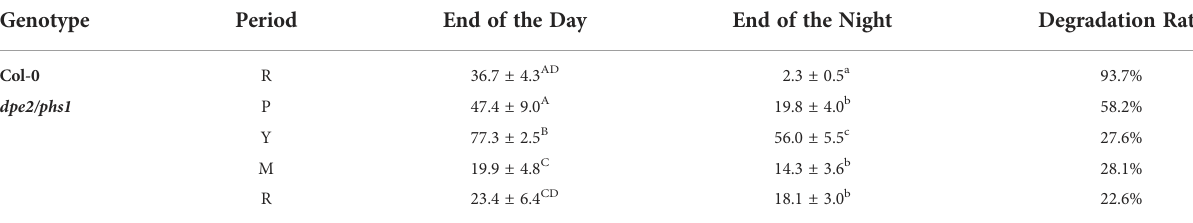
Leaveswereharvestedattheendofthelightanddarkphase.Meanvalues±SDaregiven,lettersindicatethestatisticallysigni fi cantdifferences(p ≤ 0.05)accordingtotheone-wayANOVA with Duncan ’ s post-hoc test. P, Prior Period; Y, young leaves of Reduced Granule Number Period; M, mature leaves of Reduced Granule Number Period; R, Recovery